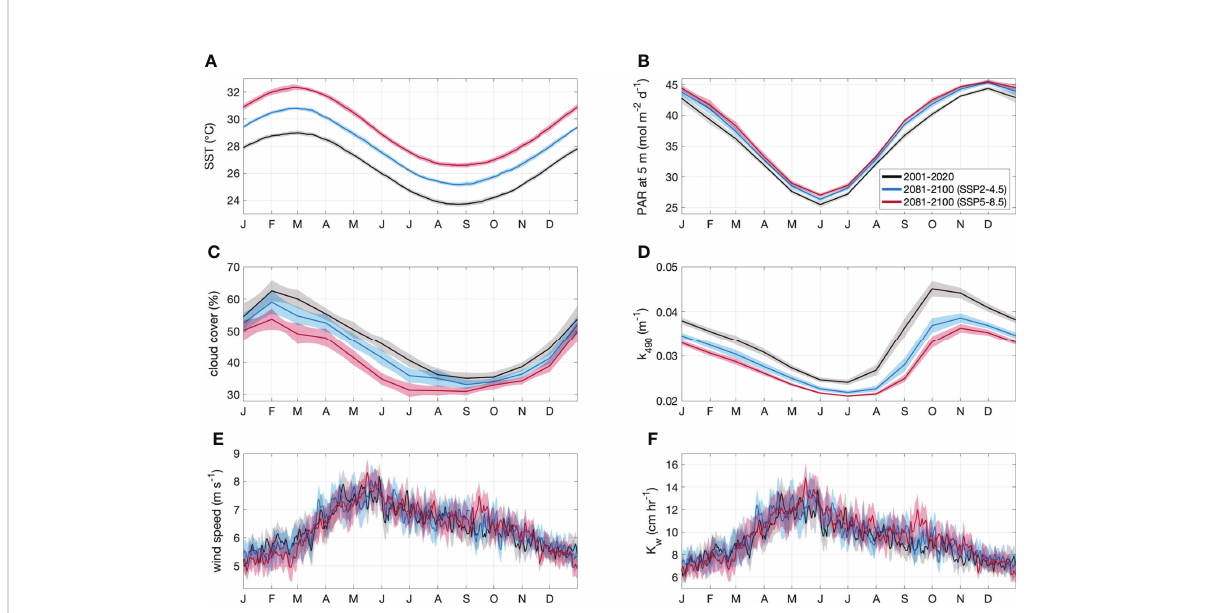
FIGURE 3 Area-averaged climatology ± 2 SE (shaded area) of (A) SST, (B) PAR at 5 m, (C) cloud cover, (D) k 490 , (E) wind speed and (F) K w for the GBRMP. Climatologies are derived from CMIP6 contemporary (black) and end of century model output for SSP2-4.5 (blue) and SSP5-8.5 (red) scenarios.